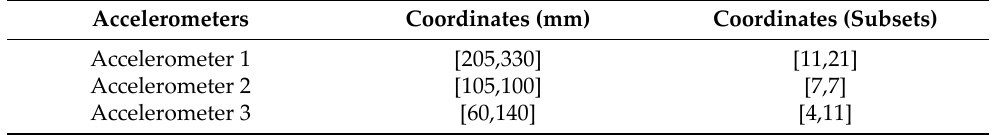
Table 1. Coordinates of the